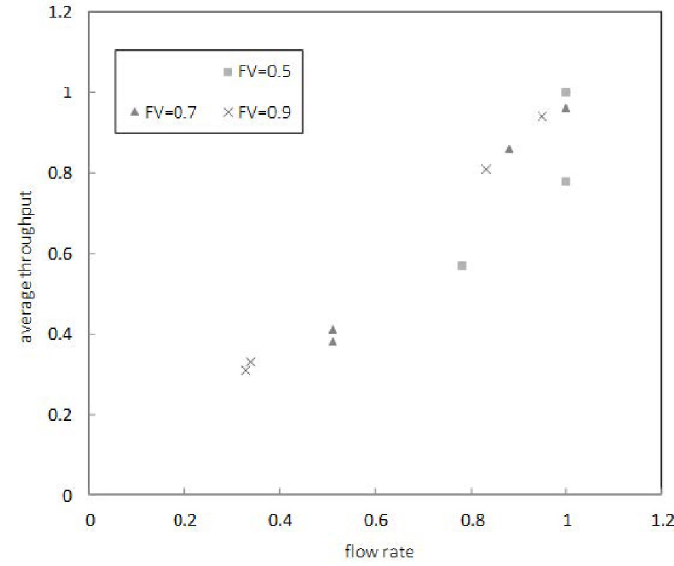
Figure 8. Average throughput with flow rate.